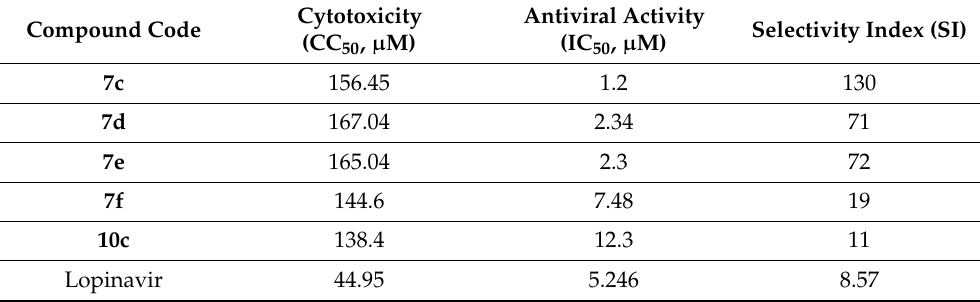
Table 1. The half maximal cytotoxic concentrations “CC 50 ” and the half maximal inhibitory concen- trations “IC 50 ” were calculated using nonlinear regression analysis on GraphPad Prism software (version 5.01, GraphPad Software, Boston, MA, USA) by plotting log inhibitor versus normalized response (variable slope). The selectivity index (SI) values were calculated for each compound by dividing its CC 50 against its IC 50